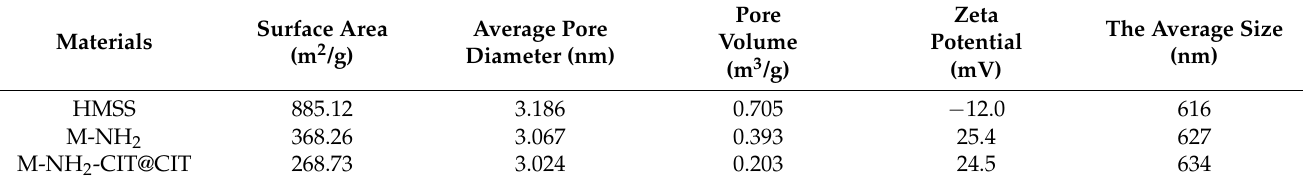
Table 1. The pore structural parameters and Zeta potential of HMSS, M-NH 2 , and M-NH 2 -CIT@CIT.